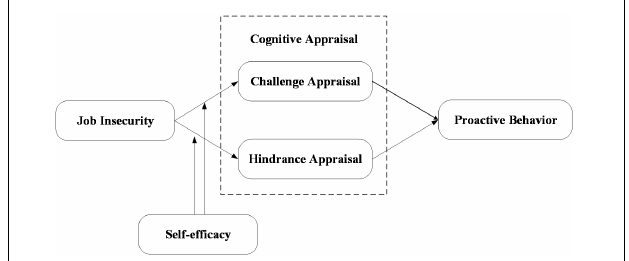
FIGURE 1 | Research model.